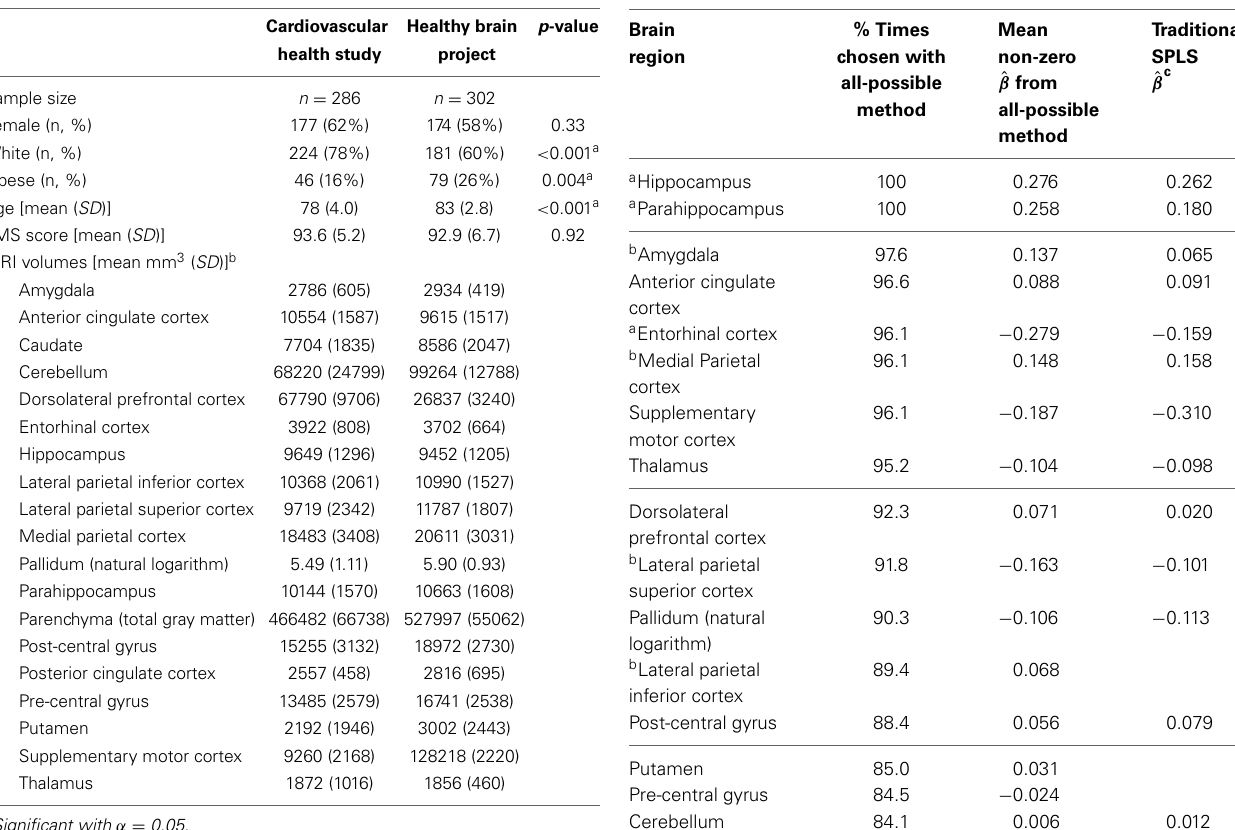
Table 2 | Demographic and MRI volumetric summaries for Cardiovascular Health Study and Healthy Brain Project participants.